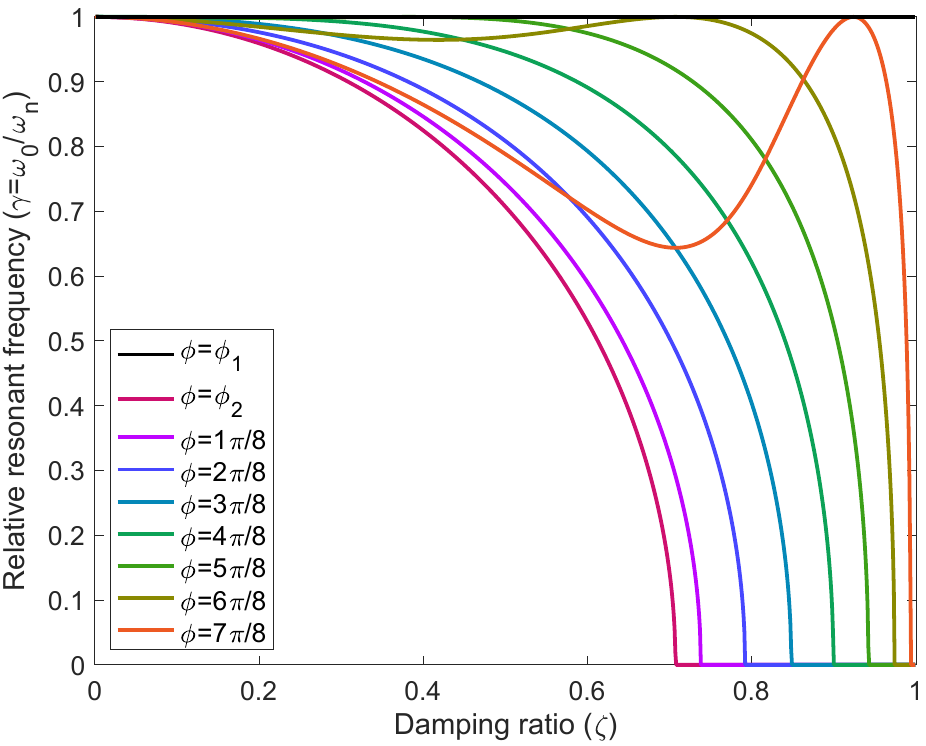
Figure 6. Relative resonant frequency ( γ = ω 0 / ω n ) of a single underdamped mode, with respect to the damping factor ( ζ ) for different phase values ( φ